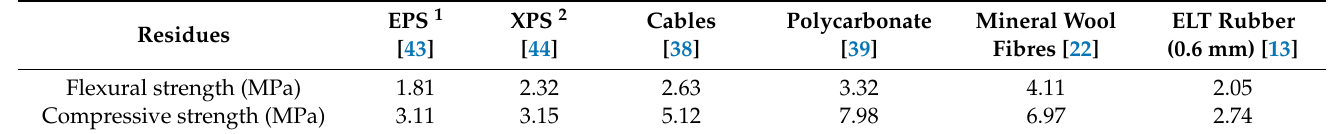
Table 7. Flexural and compressive strength results obtained in other investigations with gypsum composites as a function of the type of synthetic waste added.